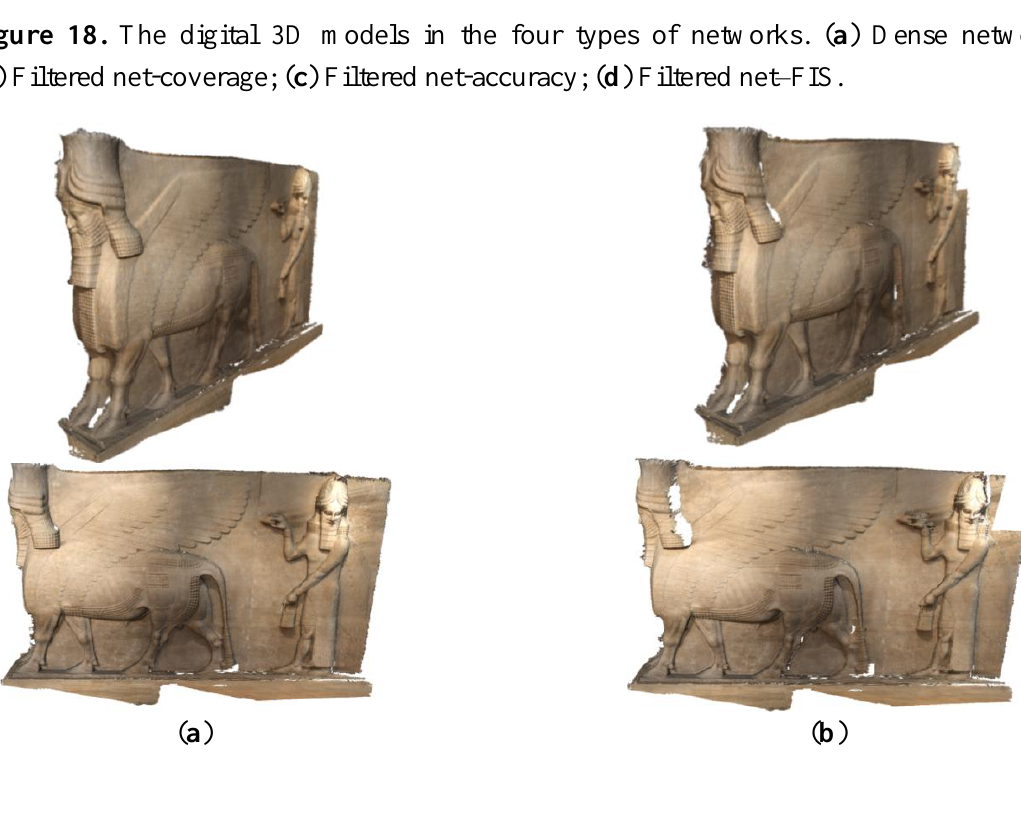
Figure 18. The digital 3D models in the four types of networks. ( a ) Dense